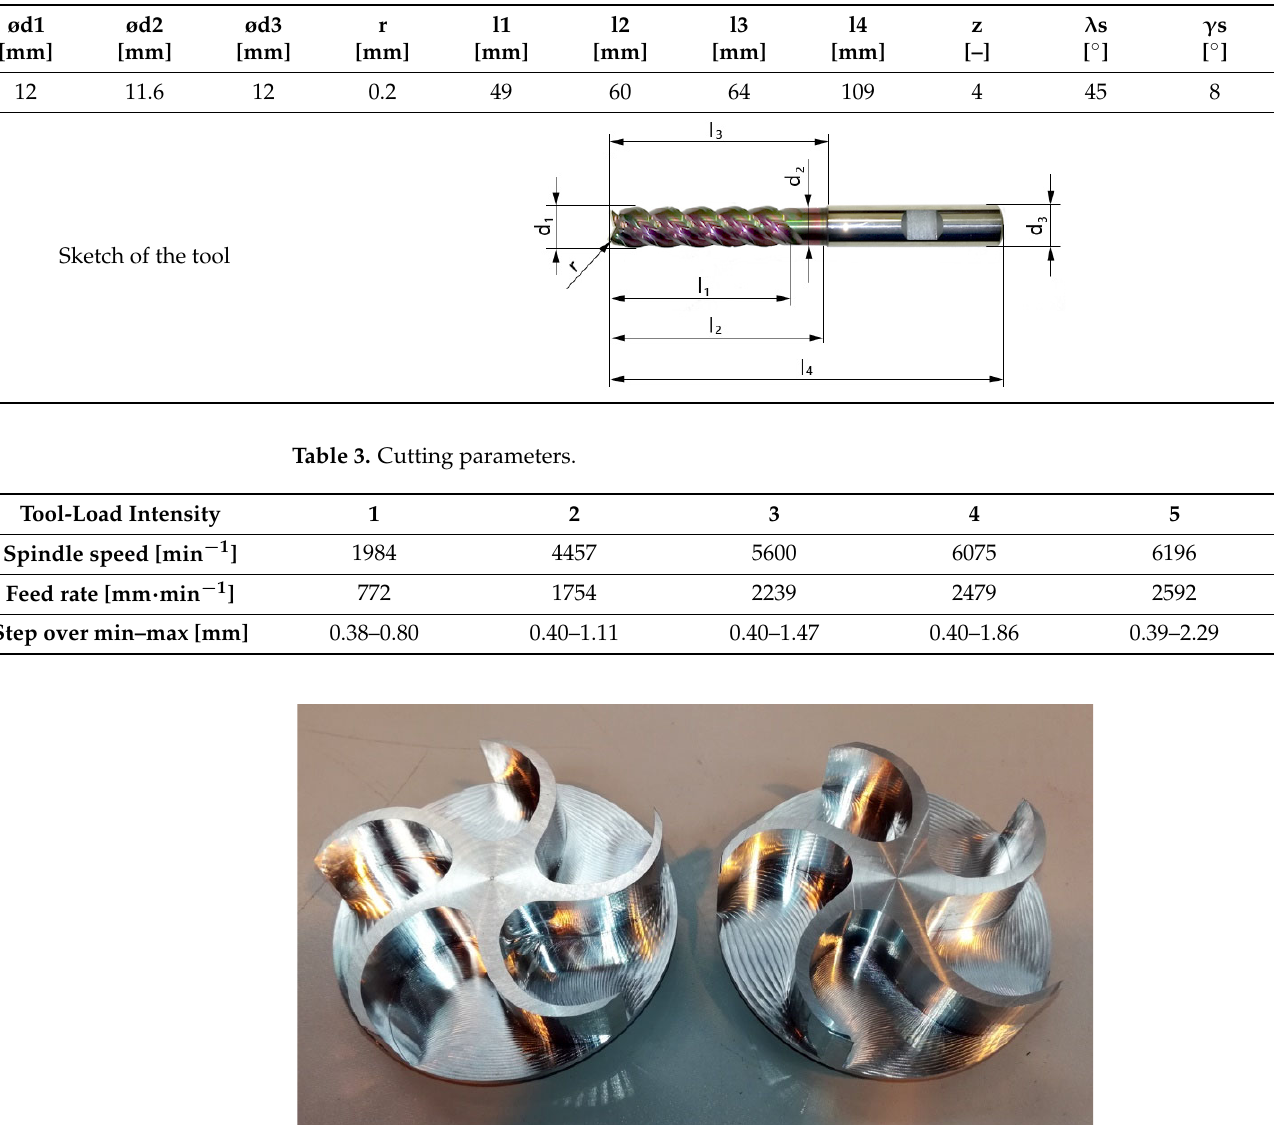
Figure 4. Machined samples—left using standard NC programs, right using optimized NC pro ‐ grams.